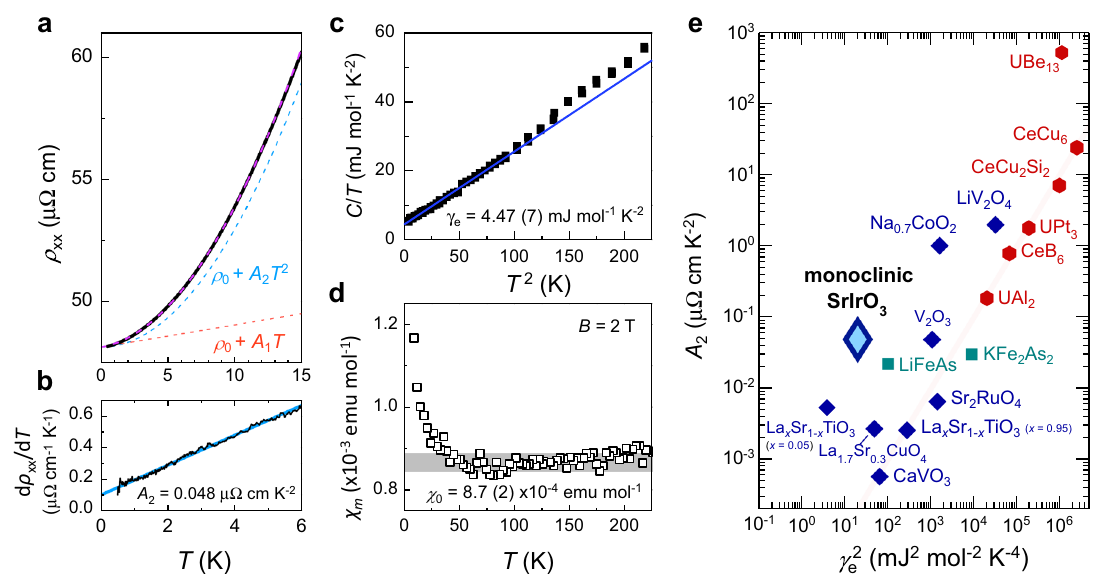
Fig. 4 Non-Fermi liquid transport and Kadowaki-Woods ratio of m -SIO 3 . a Zero- fi eld resistivity ρ xx ( T ) below 15 K and, b its derivative d ρ xx /d T below 6 K, revealing a fi nite T -linear component in ρ xx ( T ) at low T . Purple dashed line in a is a fi t to the experimental data using the functional form: ρ xx ( T ) = ρ 0 + A 1 T + A 2 T 2 , with the T -linear and T 2 -components shown in red and blue, respectively. c Speci fi c heat plotted as C / T vs. T 2 and fi tted with C / T = γ 0 + β T 2 below 10 K (blue line). d Magnetic susceptibility χ m measured with B = 2 T applied along [001]. χ m is largely T - independent down to ≈ 30K, with a constant χ 0 as marked by the grey band. Below 30 K, χ m shows a small upturn, which we attribute to an impurity contribution that follows a Curie-Weiss behaviour. e Transport coef fi cient A 2 plotted against γ 2 , known as the Kadowaki-Woods plot, 0 for selected correlated oxides (diamonds), iron pnictides (hexagons), heavy fermion materials (circles) ( 30 – 32 and references therein), and = 10 μΩ cm mol 2 K 2 mJ − 6 , known to describe many heavy fermion monoclinic SrIrO 3 (elongated diamond). Red line corresponds to A 2 = γ 2 0 materials well.